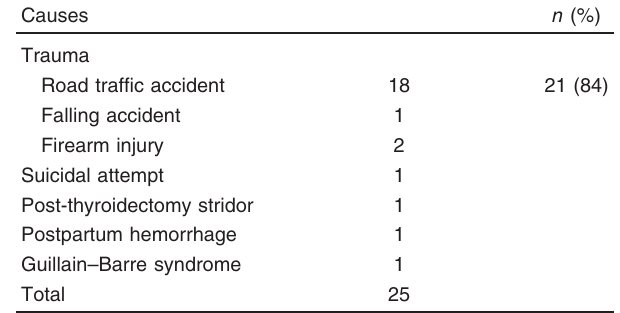
Table 1 Myer – Cotton grading system for subglottic stenosis Table 2 Causes of ICU admission and